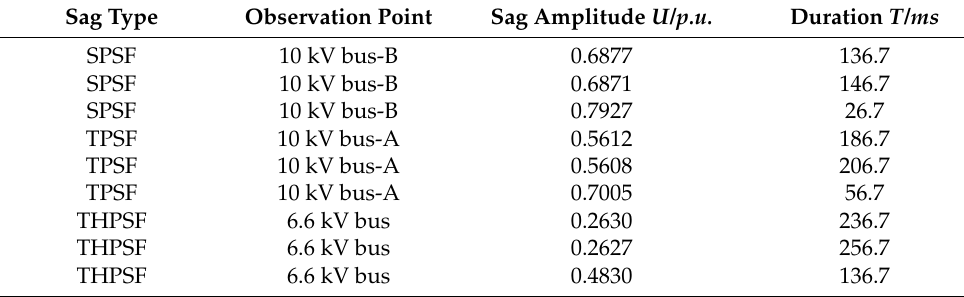
Table A1. Sag feature information at observation